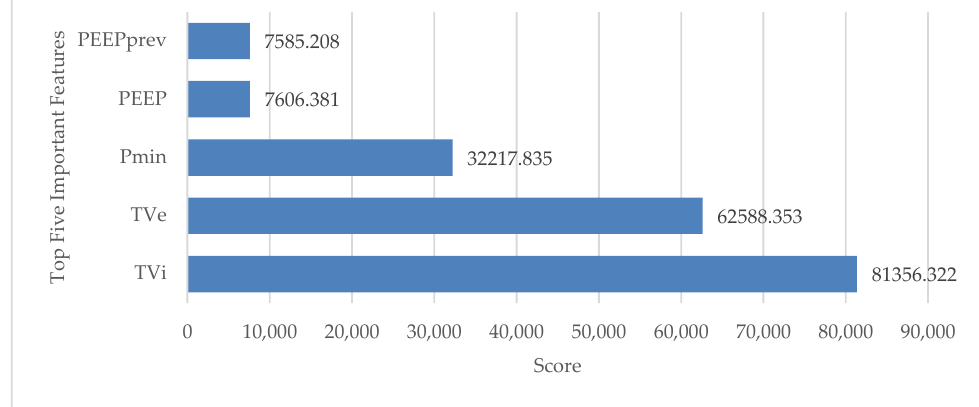
Figure 3. Top five features that mostly contributed for training ML algorithm. Those five features were inspiratory tidal volume (TVi), expiratory tidal volume (TVe), PEEPprev value, minimum pressure value (Pmin) and positive end-expiratory pressure (PEEP). All the data files were segregated, and each row was annotated as one of these five modes: pressure control mode (PC), volume control mode (VC), pressure